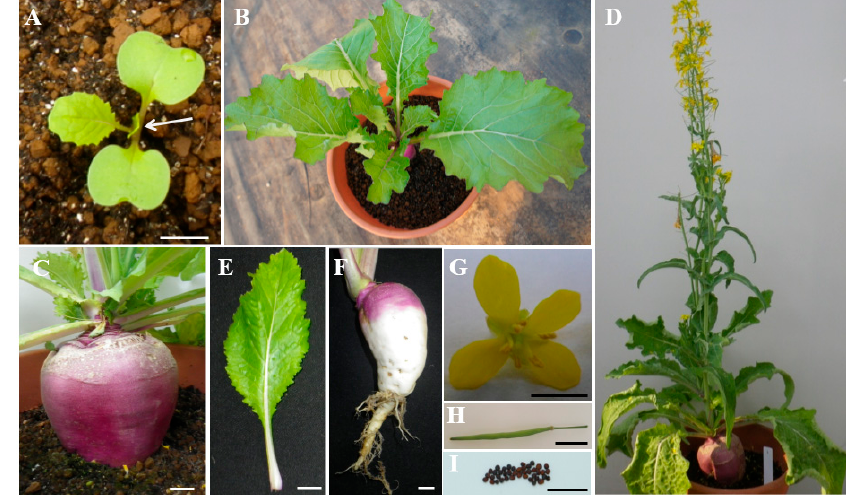
Figure 1. Turnip cultivar “Tsuda” plant development: ( A ) turnip seedlings; ( B ) vegetative growth of plants; ( C ) root swelling stage; ( D ) main shoot of flowering plant; ( E ) fully expanded rosette leaf; ( F ) light-induced anthocyanin accumulation in swollen root; ( G ) bright-yellow flower; ( H ) silique; and ( I ) mature seeds. The white arrow in ( A ) indicates the growing point of seedlings. Bar = 0.5 cm.